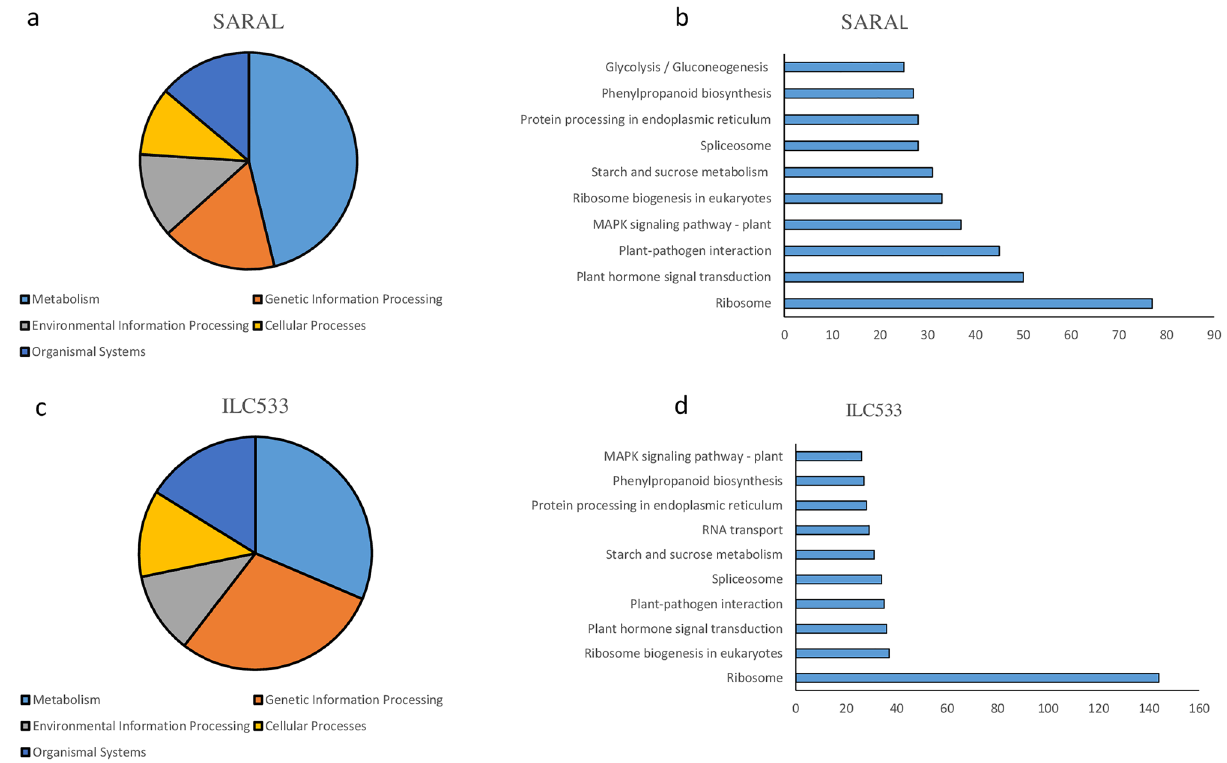
Figure 3. Classification of the DEGs in KEGG pathways: ( a ) and ( c ) Distribution of the DEGs into five main KEGG classes in Saral and ILC535, respectively. ( b ) and ( d ) The top 10 KEGG pathways having the highest number of